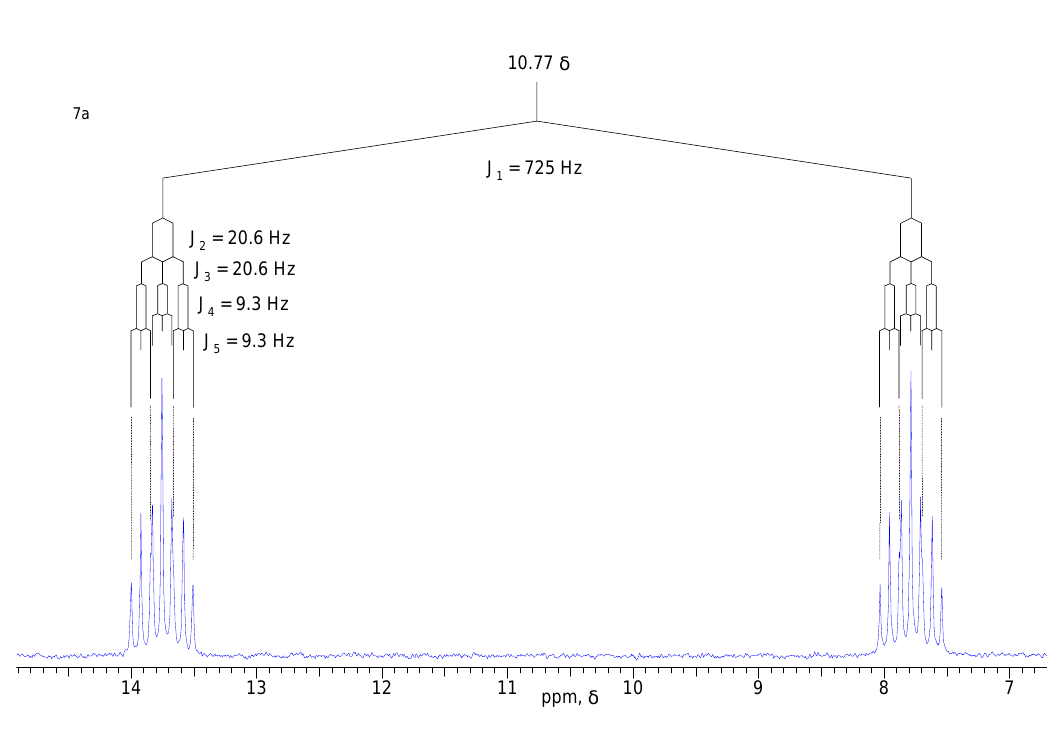
Figure 1. 31 P NMR spectrum of